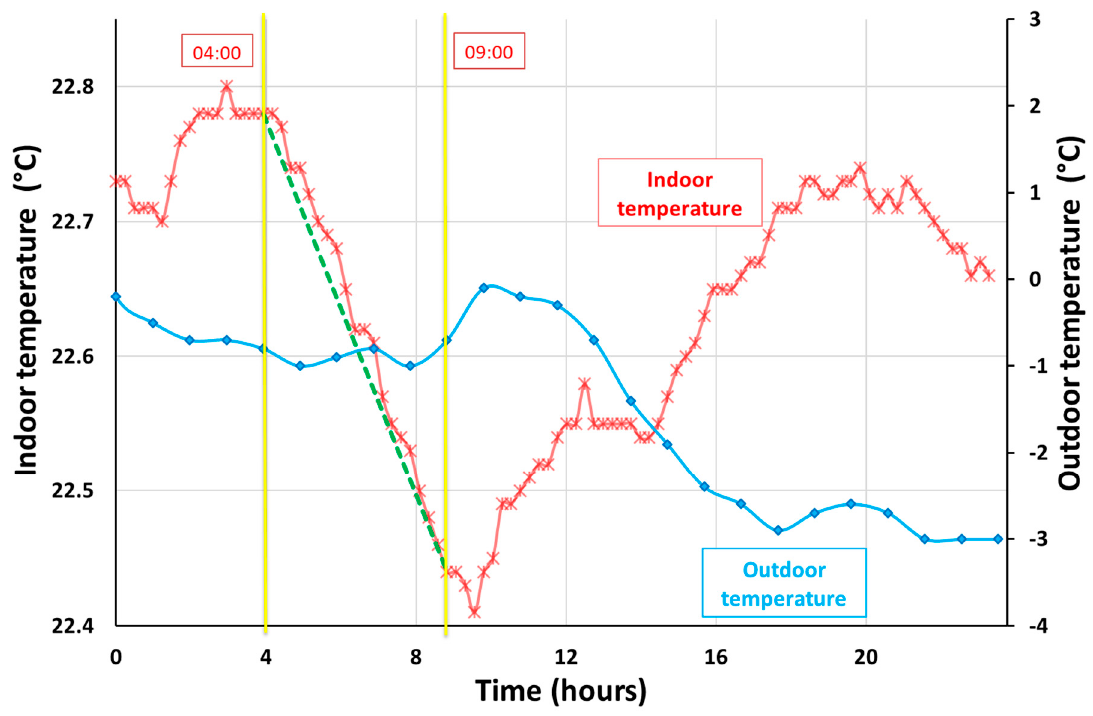
Figure 5. Indoor temperature for the studied building both before and during the temperature decay.